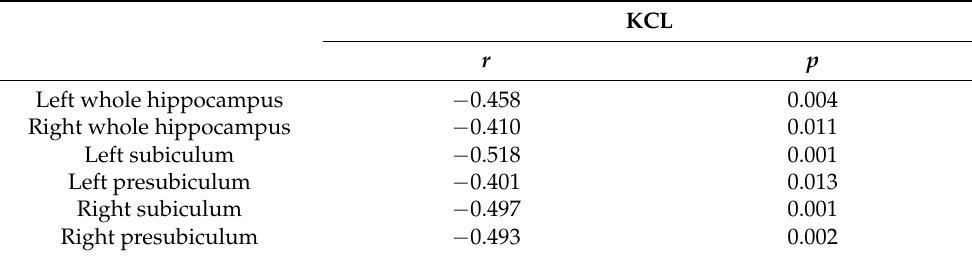
Table 3. Correlations between volume of hippocampal subfields and KCL